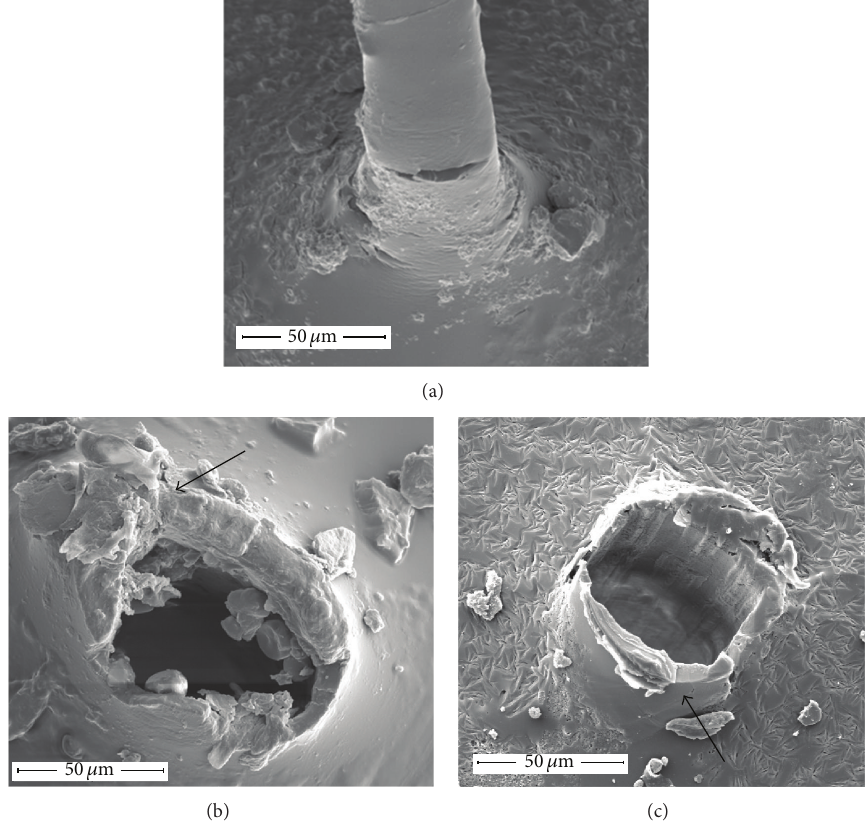
Figure 8: SEM micrographs of a mendong fiber pull-out specimen. (a) Fiber embedded in epoxy, (b) cavity in nontreated epoxy after pull-out test, and (c) cavity in treated epoxy using AC electric fields 750 V/cm after pull-out